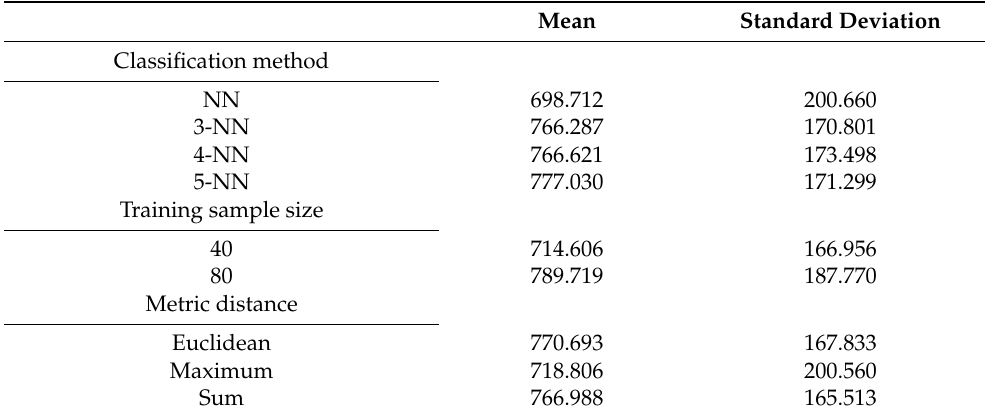
Table 3. Comparison of means for stem classification scores produced by different classification methods, training sample sizes, and metric